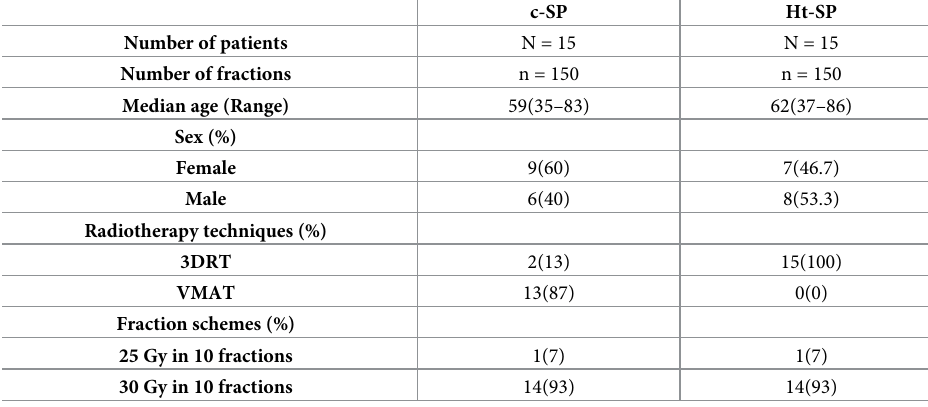
Table 1. Characteristics of the patients and treatment included in this study.